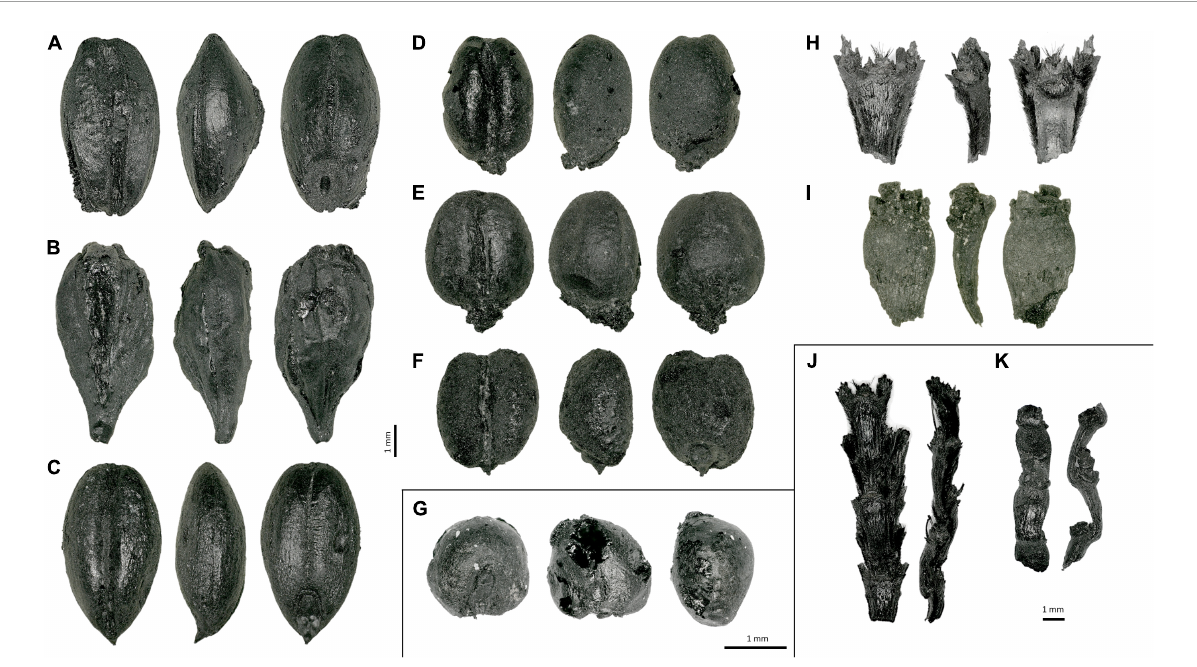
FIGURE4 Domesticated grains present in the assemblage: (A) Hordeum vulgare var. vulgare , (B) H. vulgare var. vulgare with glume attached, (C) H. vulgare var. nudum , (D) Triticum aestivum , (E,F) T. aestivum (highly compact variety), (G) Panicum miliaceum , (H) six-row barley rachis, (I) free-threshing wheat rachis, (J) barley rachis internodes, and (K) free-threshing wheat rachis